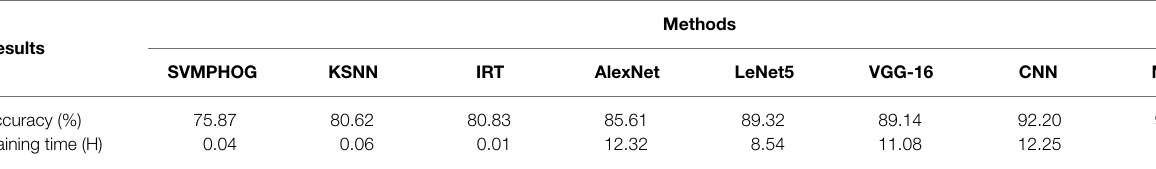
TABLE 2 | The average recognition accuracy and training time of apple disease on YangLing dataset by seven methods.